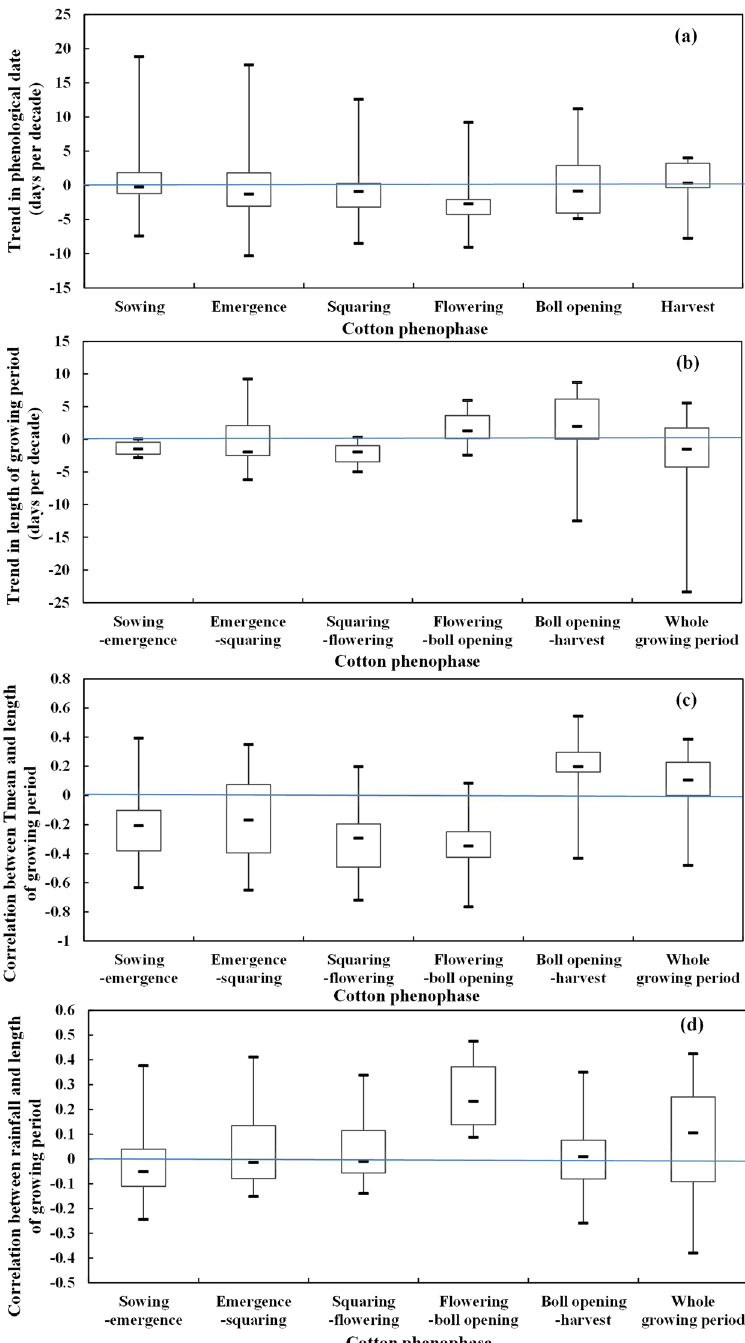
Figure 1. Trends in phenological dates ( a ) and the length the of growing period ( b ), correlations between Tmean and the length of the growing period ( c ), and correlations between rainfall and the length of growing period ( d ). The blue line is the zero line. Trends above or below the line represent a delay or advance, respectively, in phenology ( a ) or a prolonged or shortened growing period ( b ). The correlation coefficients above or below the line represent a positive or negative correlation ( c,d